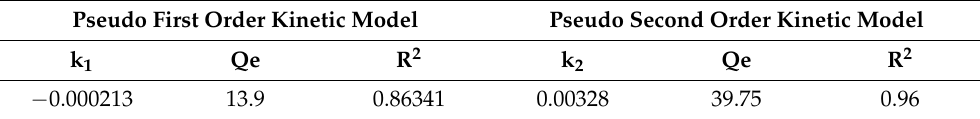
Figure 9. ( a ) Pseudo-first-order kinetic model. ( b ) Pseudo-second-order kinetic model for the adsorption of MR on D. viscosa plant bark powder. Table 1. The kinetic parameters for the adsorption of MR on the D. viscosa plant bark powder.